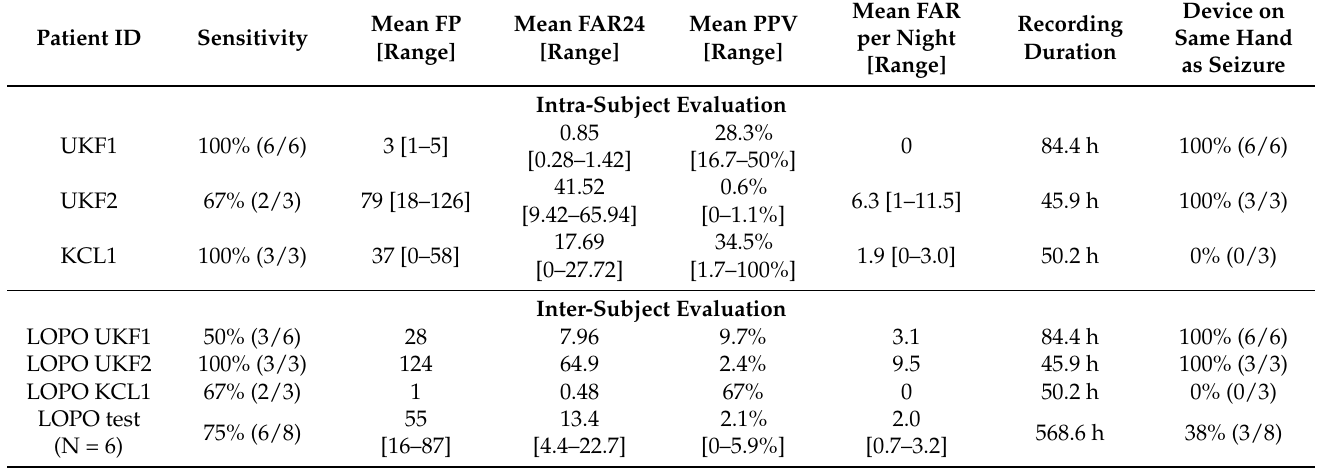
Table 1. Evaluation results for the intra-subject leave-one-seizure-out evaluation, and the inter-subject leave-one-participant-out evaluation, respectively. Means and ranges are always across the single folds of the validations, that is, across the held-back data for the first part and across the held-back data, and test set participants, in the second part. FP: false positive; FAR24: false alarm rate per 24 h; PPV: positive predictive value; FAR: false alarm rate; LOPO: leave-one-patient-out